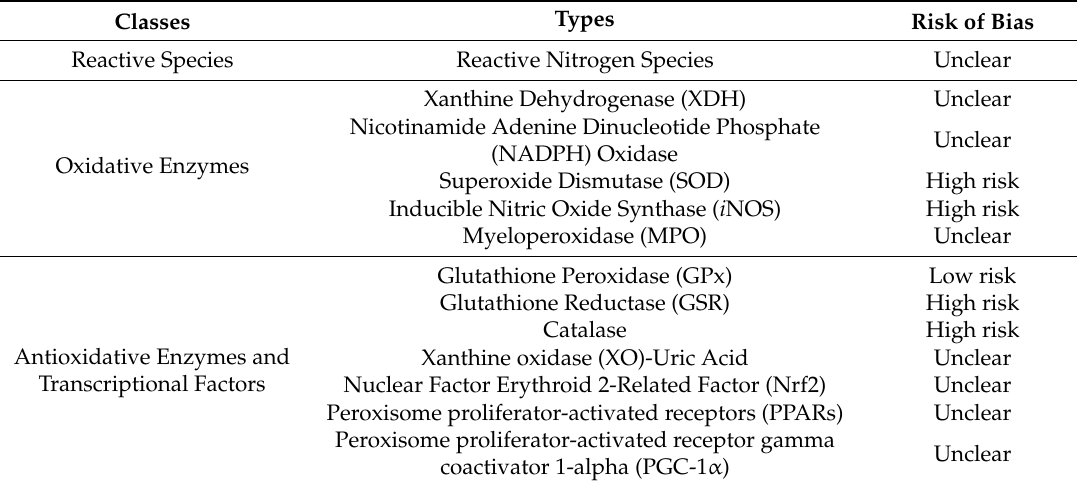
Table A1. Classes and biomarkers, and risk of bias assessment included in this